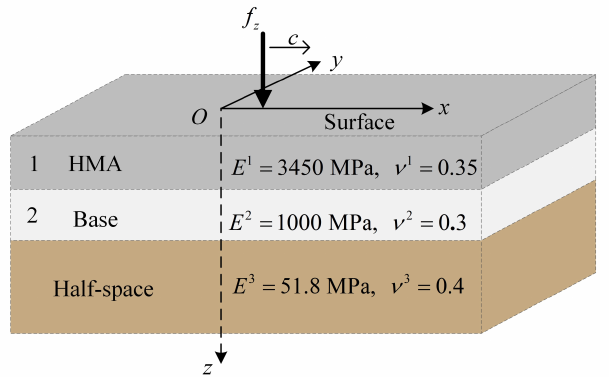
Figure 9. Research models of the road